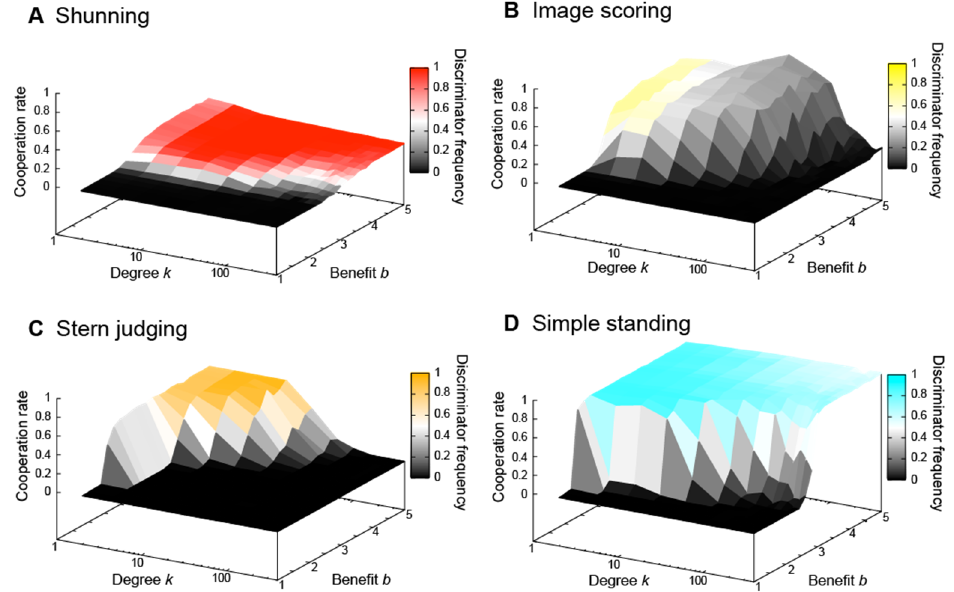
Figure 3. Cooperation rates and Discriminator frequencies in direct observation and private assessment errors. ( A ) Shunning can take over the entire population yet only achieve, at most, a low cooperation rate; ( C ) stern judging can achieve almost full cooperation, as can Discriminator frequency if, and only if, benefits b and node degrees k are sufficiently high and low, respectively; otherwise, both the cooperation rate and the Discriminator frequency reduce to zero; ( D ) simple standing can achieve full cooperation and 100% Discriminators for a broad range of parameters, as Cooperators and Discriminators (see also Figure 5B). Parameters: error rates p = q = 0.01 (both